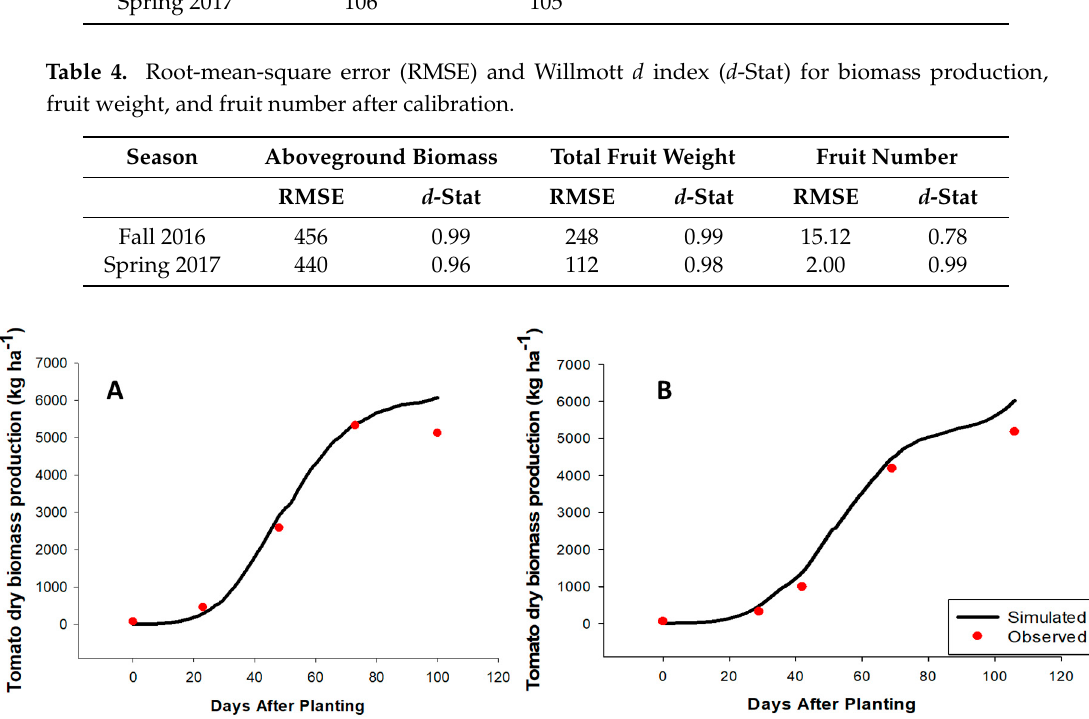
Figure 2. Results of the model calibration for the aboveground biomass accumulation during the fall 2016 ( A ) and spring 2017 ( B ) seasons of drip ‐ irrigated fresh ‐ market tomato production in Immokalee, Florida.